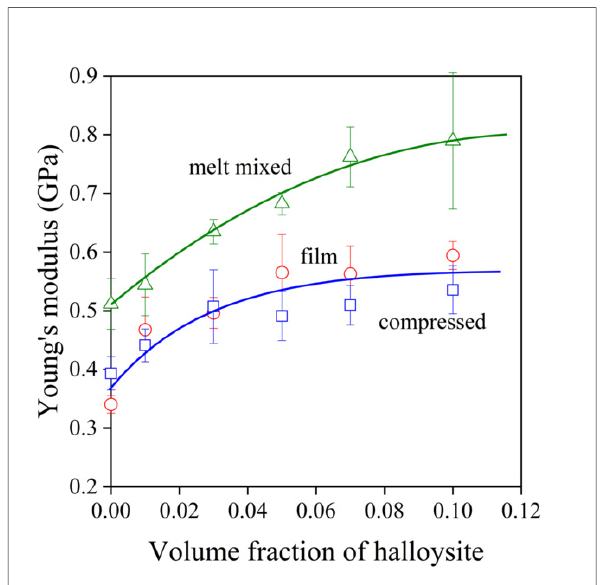
Figure 7. Effect of halloysite content on the stiffness of PCL/halloysite composites. Symbols: ( ) film, ( ) compressed, ( ) melt mixed.